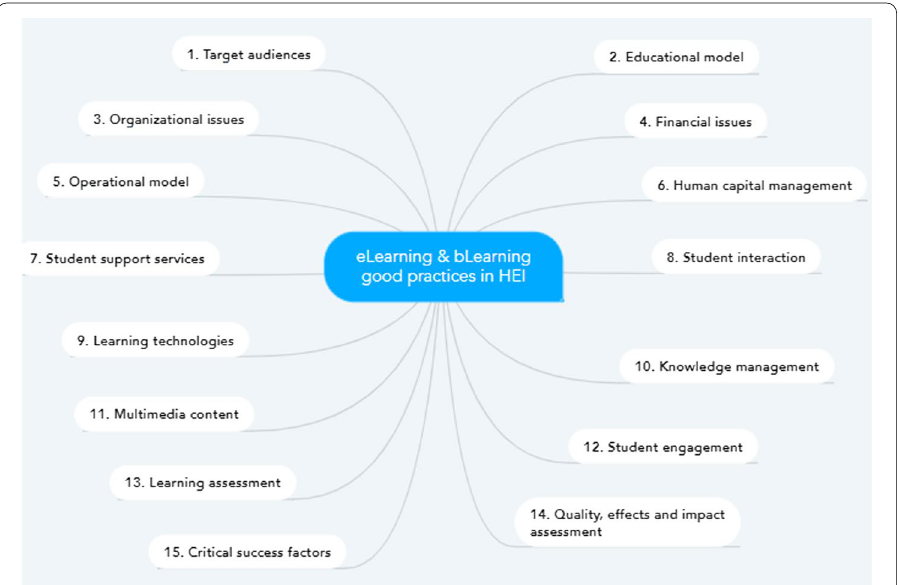
Fig. 1 Mind map with objects of inquiry and analysis of good practices in eLearning and bLearning in HEI. Source: Translated from Galvis (2019, p.